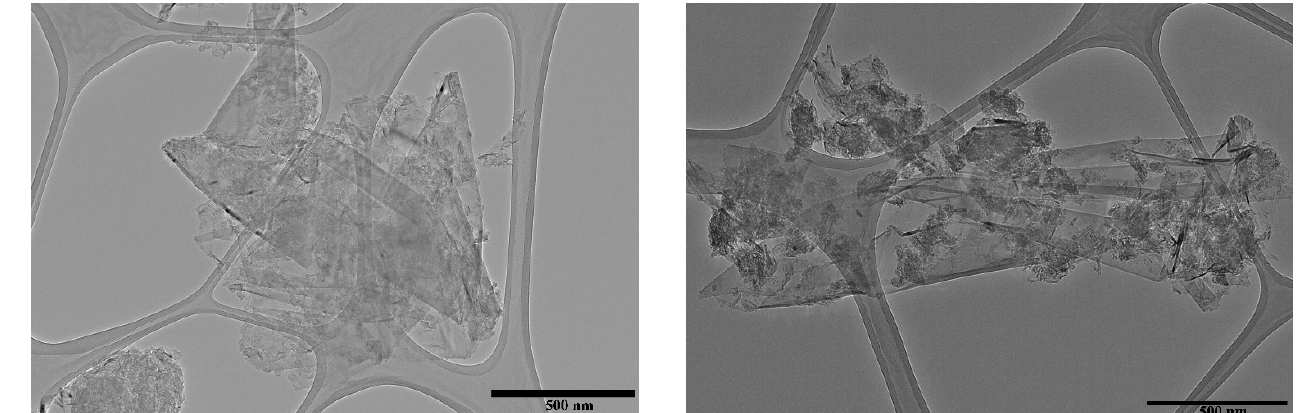
Figure 2. Transmission electron microscopy (TEM) micrographs of GNP used in drilling mud.